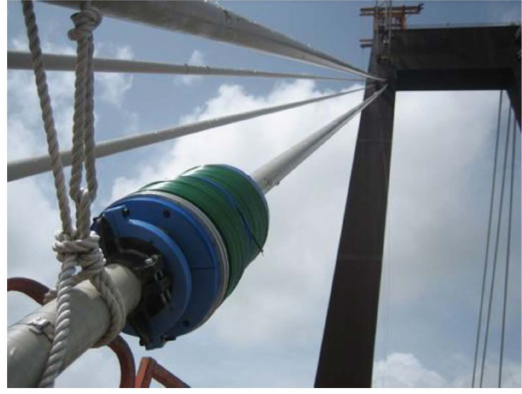
Figure 24. MFL application for a cable steel bridge